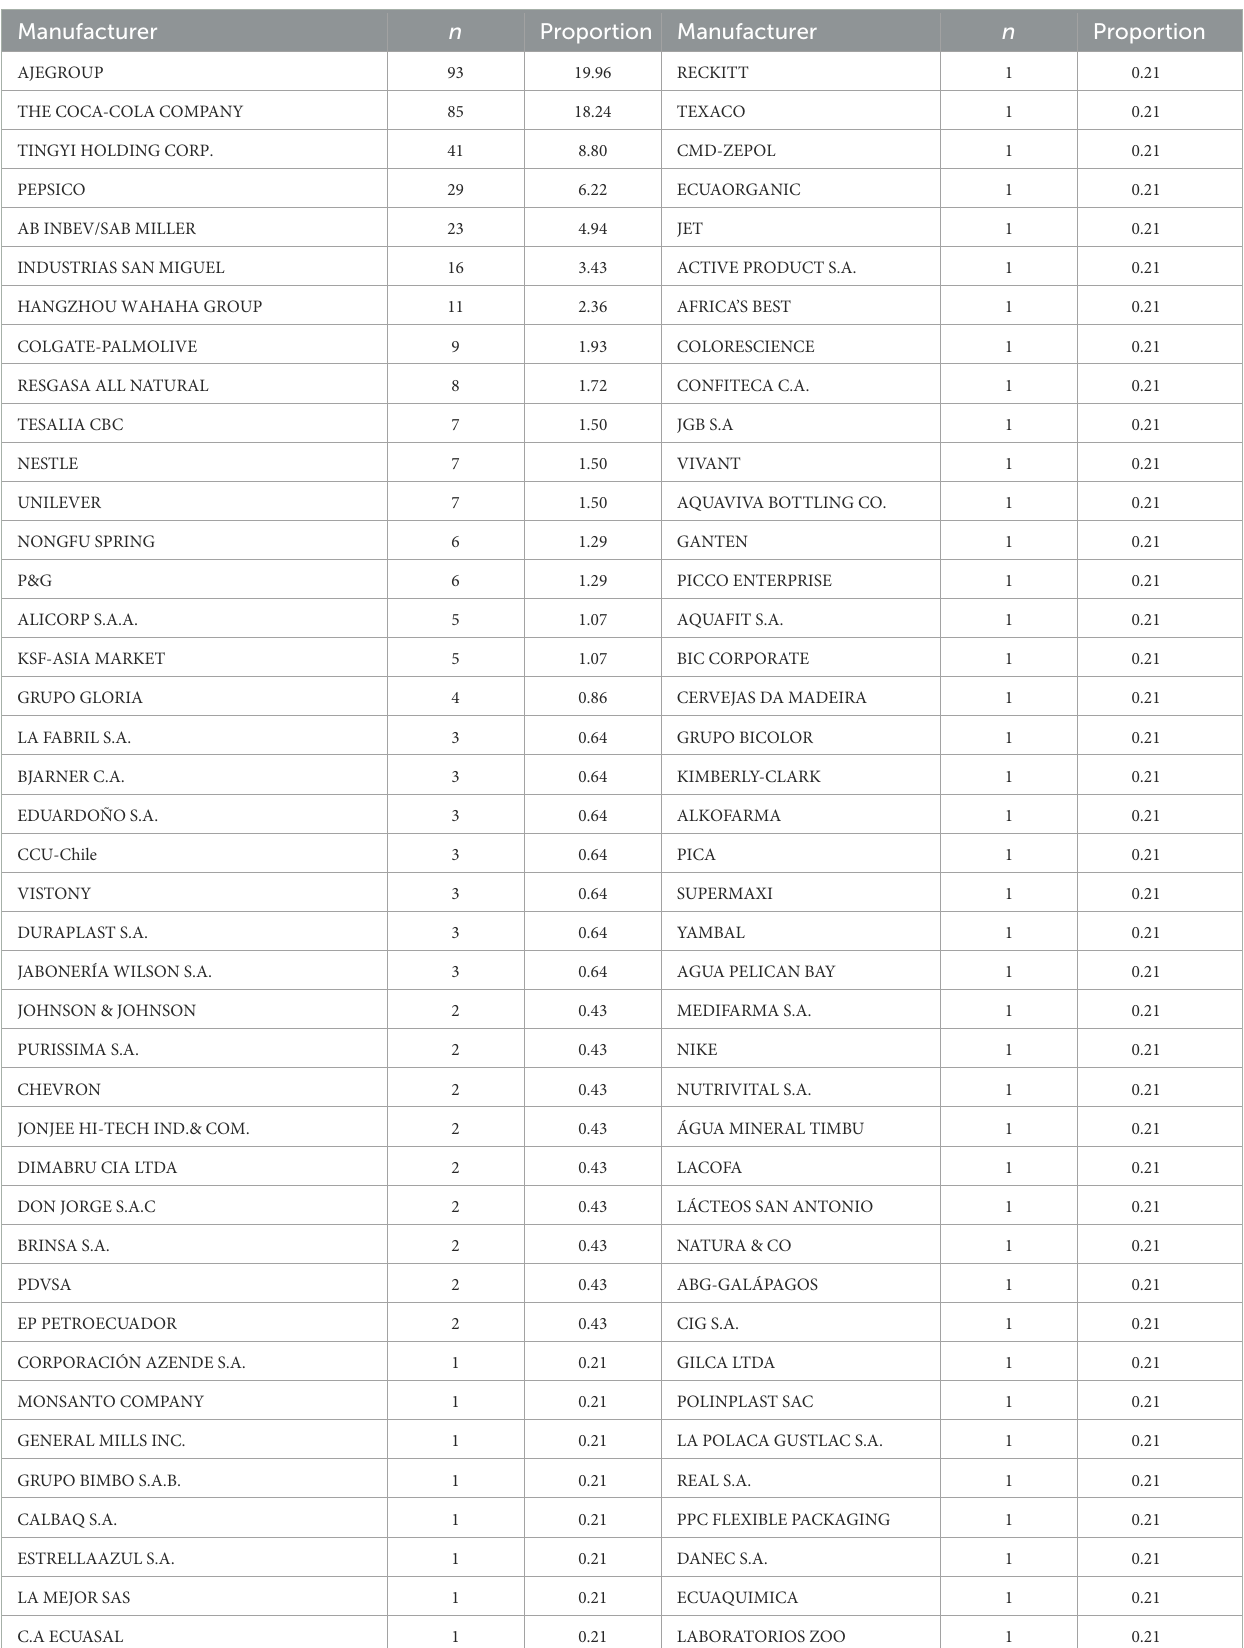
TABLE 3 Ranking of 98 manufacturers from 466 macroplastic items collected from the Galápagos Archipelago, in which information could be